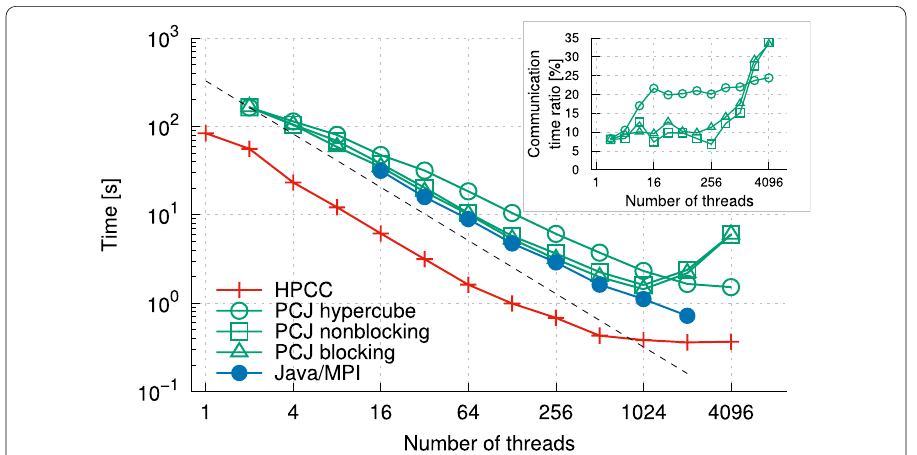
Fig. 6 Performance of the 1D FFT implemented using different algorithms. The data for the HPCC implementation using C/MPI as well as Java/MPI is presented for reference. The array of 2 30 elements was used. Ideal scaling for PCJ is drawn (dashed line). Inset presents communication time as a percentage of total execution time. The benchmarks were run on Cray XC40 at